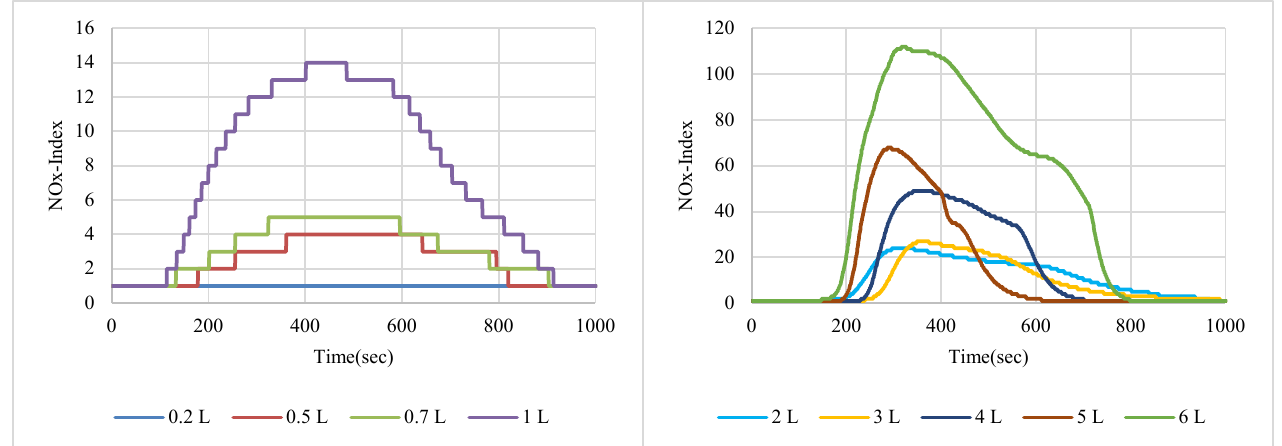
Figure 8. NOx-Index response for NOx car exhaust gas sample 1.